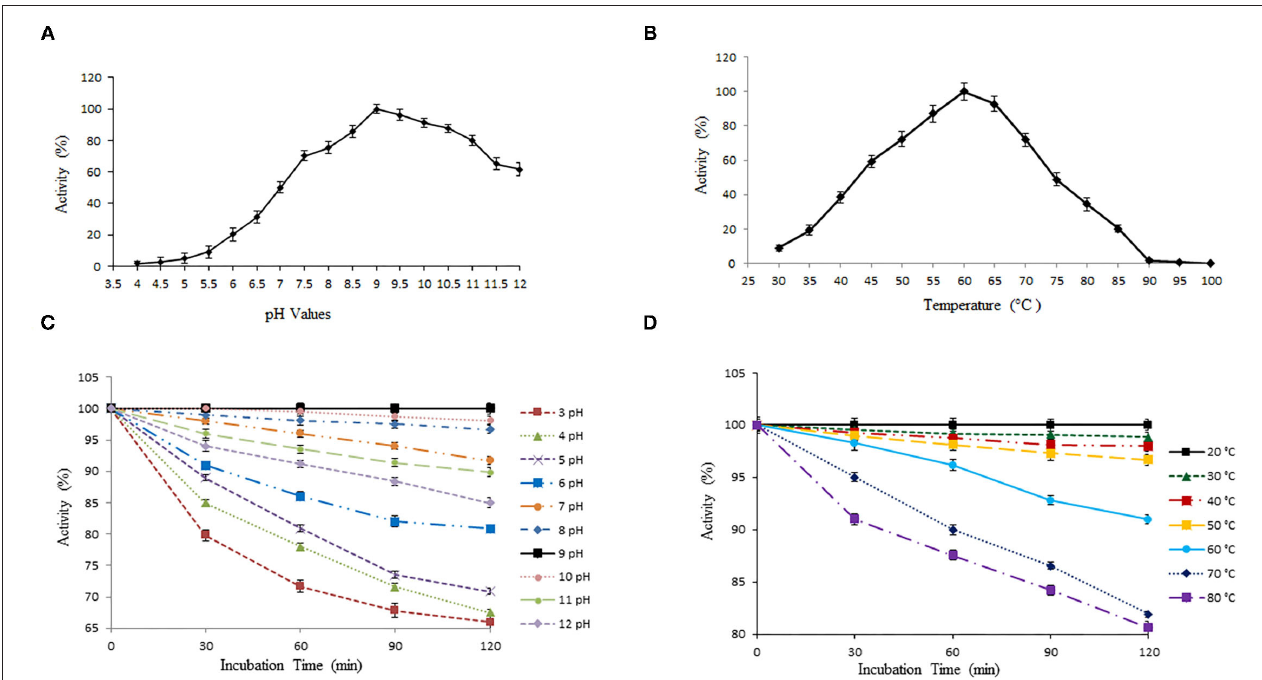
FIGURE 3 | Effect of temperature and pH on activity and stability of keratinase. (A,B) The optimal activity of keratinase was observed at pH 9 and 60 ◦ C. (C,D) Keratinase exhibits stability within wide pH (3–12) and temperature (20–80 ◦ C) range.